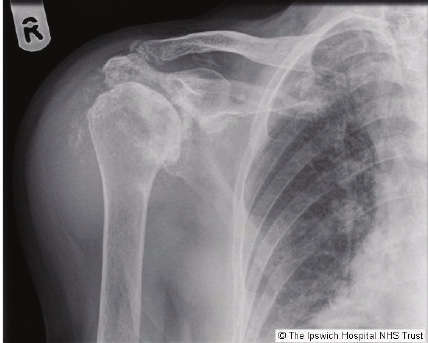
Figure 2: Submission remains copyrighted by the Ipswich Hospital NHS trust as per trust policy—we have permission from the patient and also from the trust to publish.